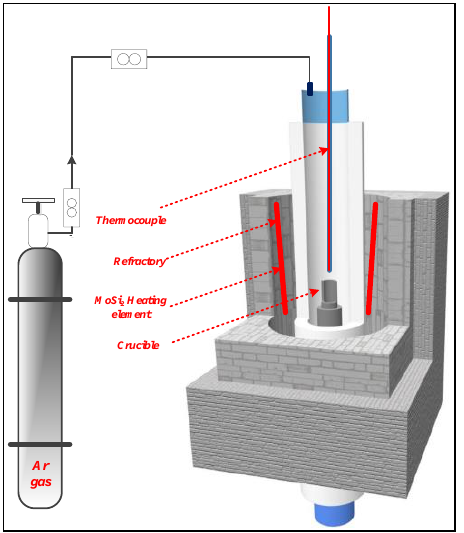
Figure 2. Schematic diagram of the smelting furnace.